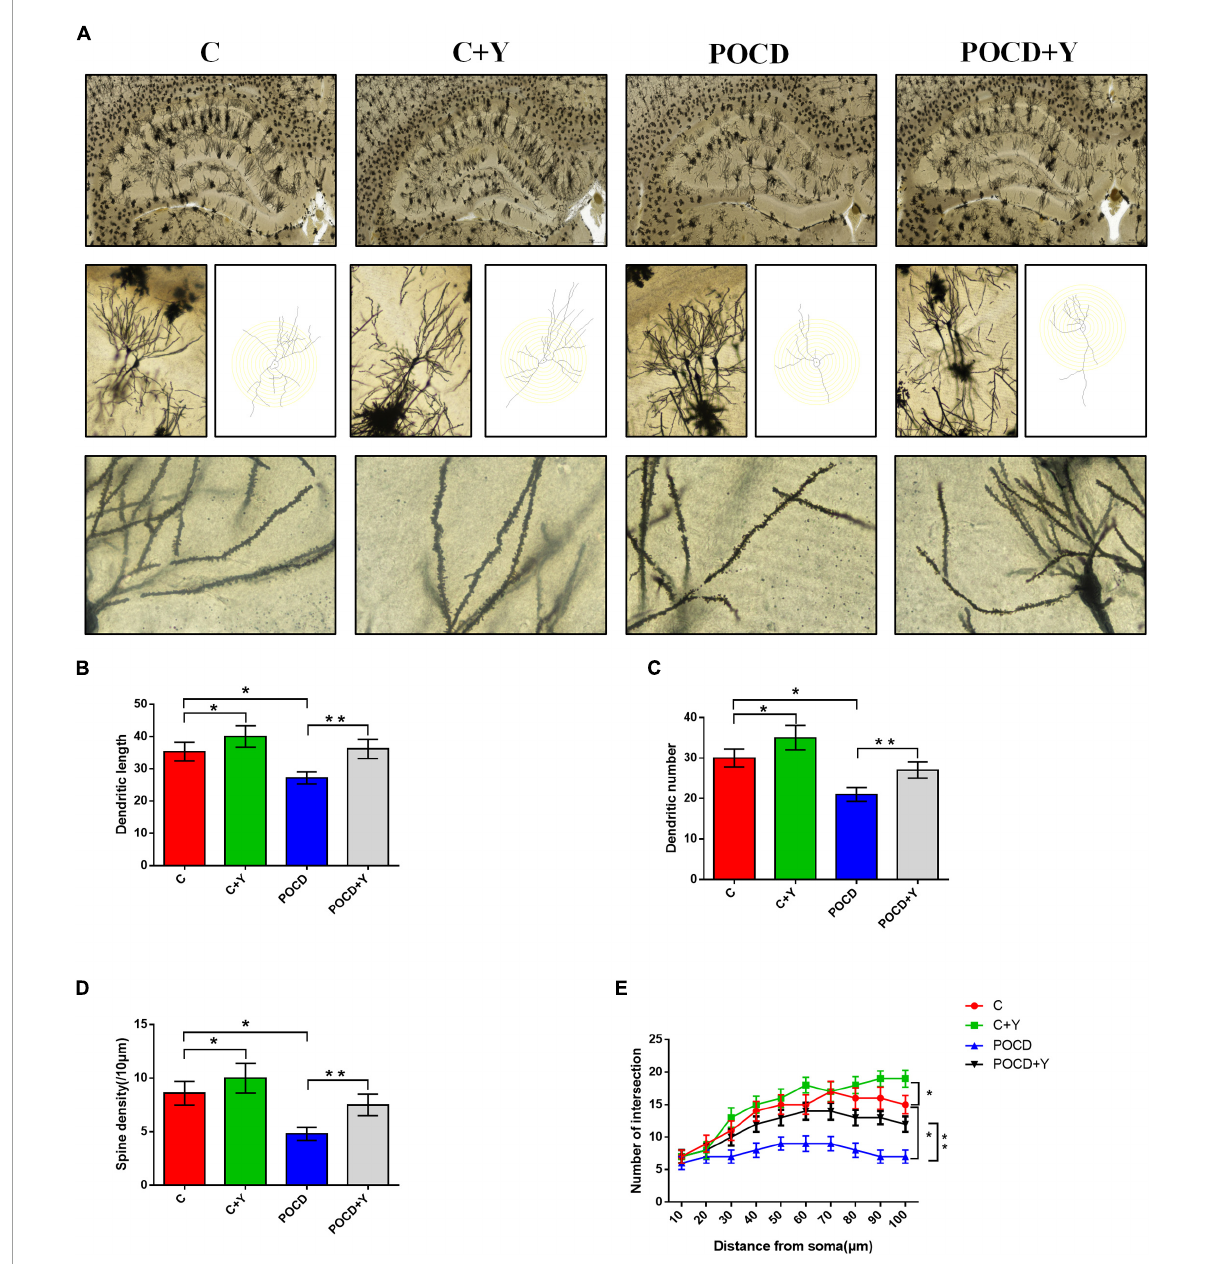
FIGURE5 Young plasma alleviated dendritic and spine deficits in the hippocampus of postoperative cognitive dysfunction (POCD) rats. (A) Representative hippocampal Golgi-Cox staining images showing dendritic arborization in hippocampal CA1 pyramidal neurons and an intersection diagram of dendritic arborization and concentric circles in hippocampal slices. Scale bar: 400 µ m and 50 µ m for enlarged inserts. (B) Quantification of the dendritic length of hippocampal CA1 pyramidal neurons. (C) The number of dendrites in hippocampal CA1 pyramidal neurons. (D) Spine density of dendrites in hippocampal CA1 pyramidal neurons. (E) Quantitative analysis of the number of intersections of dendrites in hippocampal CA1 pyramidal neurons. Data are shown as means ± standard deviations. * p < 0.05 compared with group C, ** p < 0.05 compared with group POCD ( n = 8 per